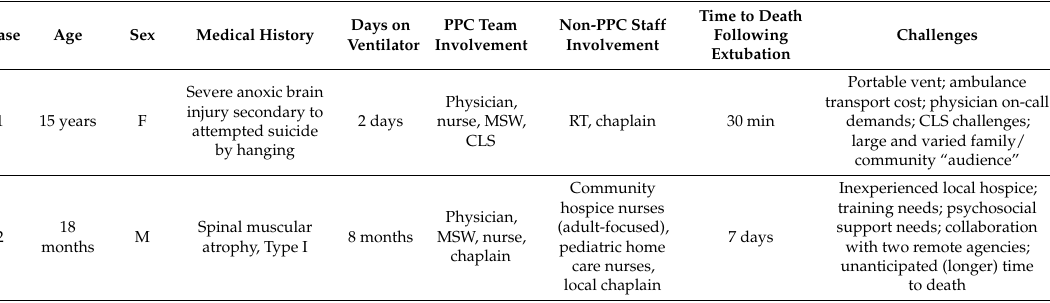
Table 1. Patient and Family